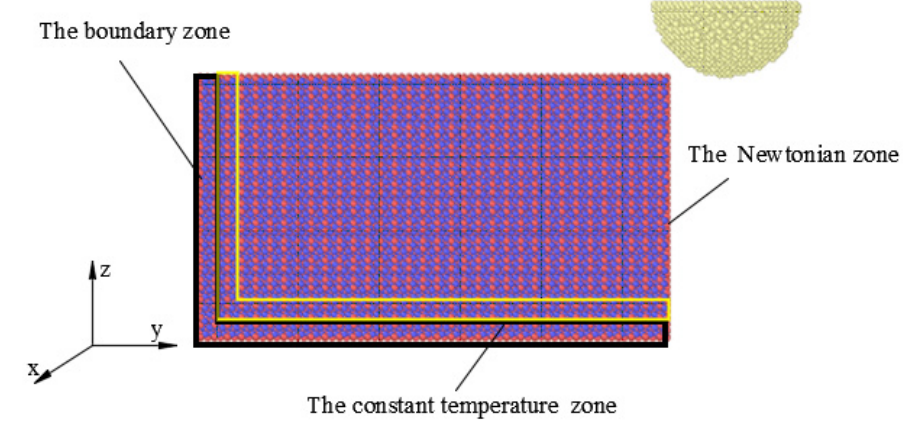
Figure 4. Three-dimensional cutting model.